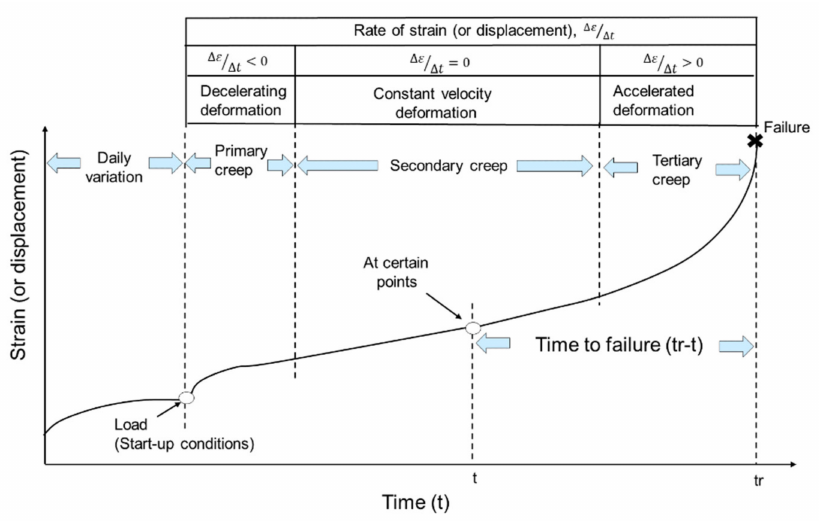
Figure 6. Strain-time curve in large-scale landslides (modified from Saito,